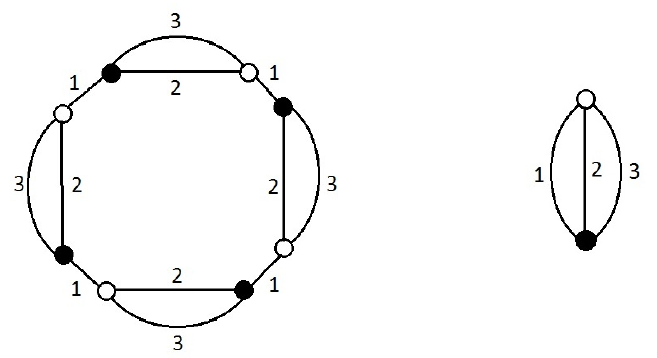
Figure 1 . The above (cid:12)gures label gauge invariant operators in the tensor model gauge theory. Black dots correspond to (cid:22) (cid:30) ijk ’s and white dots to (cid:30) ijk s. A line labeled by i is a gauge index for U( N i ). The operator on the left corresponds to (cid:22) (cid:30) i 1 j 1 k 1 (cid:30) i the operator on the right corresponds to (cid:22) (cid:30) ijk (cid:30) ijk